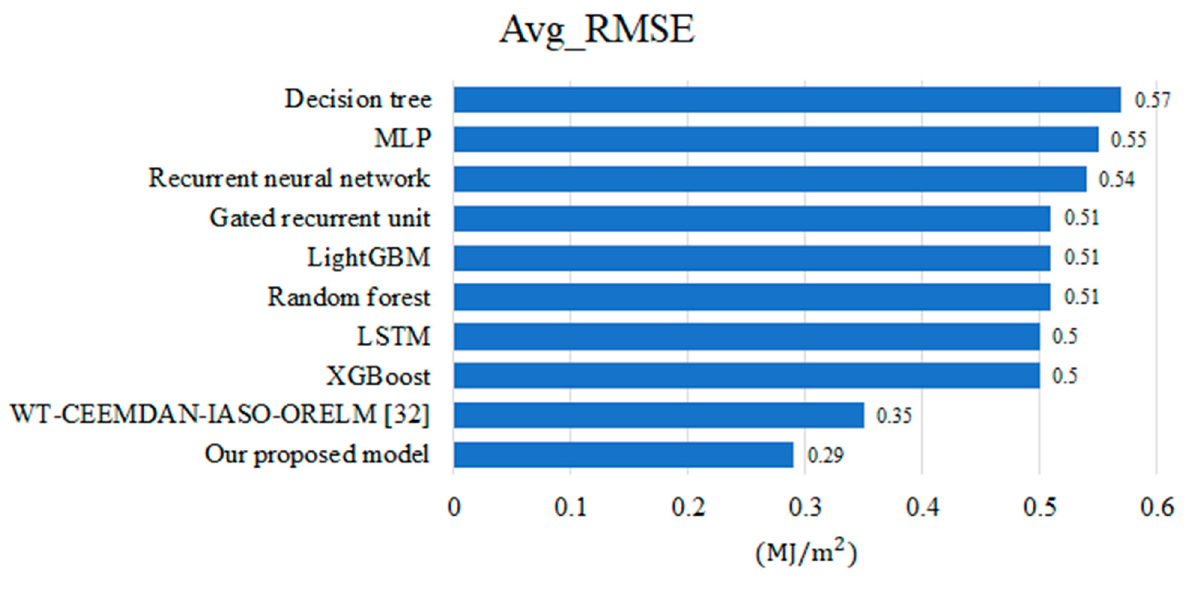
Figure 8. Average NRMSE comparison of solar radiation forecasting models (%).